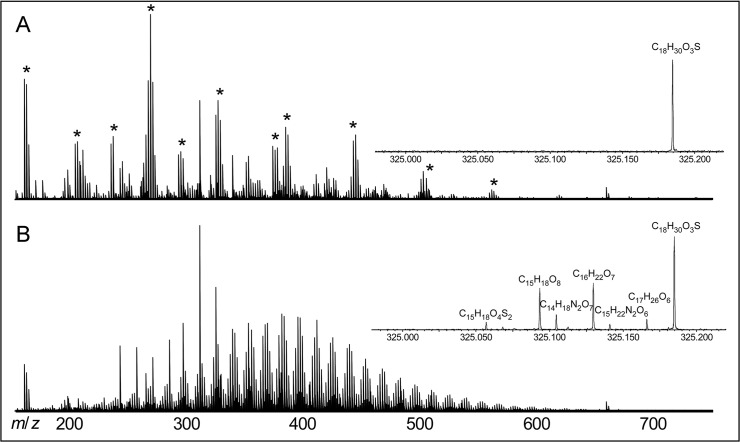
FT-ICR mass spectra (negative electrospray ionization) from the time points t0 of (A) artificial seawater and (B) natural seawater.Asterisks indicate inorganic trace impurities. Inserts show a zoom into the region of mass 325.0 to 325.2 Da. In the negative mode inorganic contaminations suppressed the ionization of organic substances present in low amounts in the artificial seawater.